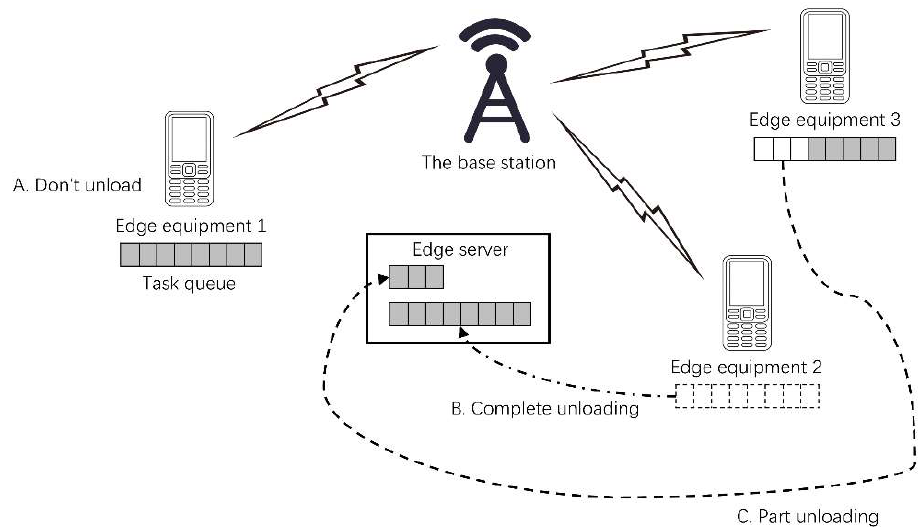
Figure 1. Three unloading strategies.